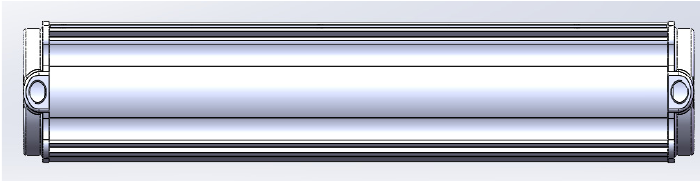
Figure 3. Three-dimensional structure of molecular sieve bed.